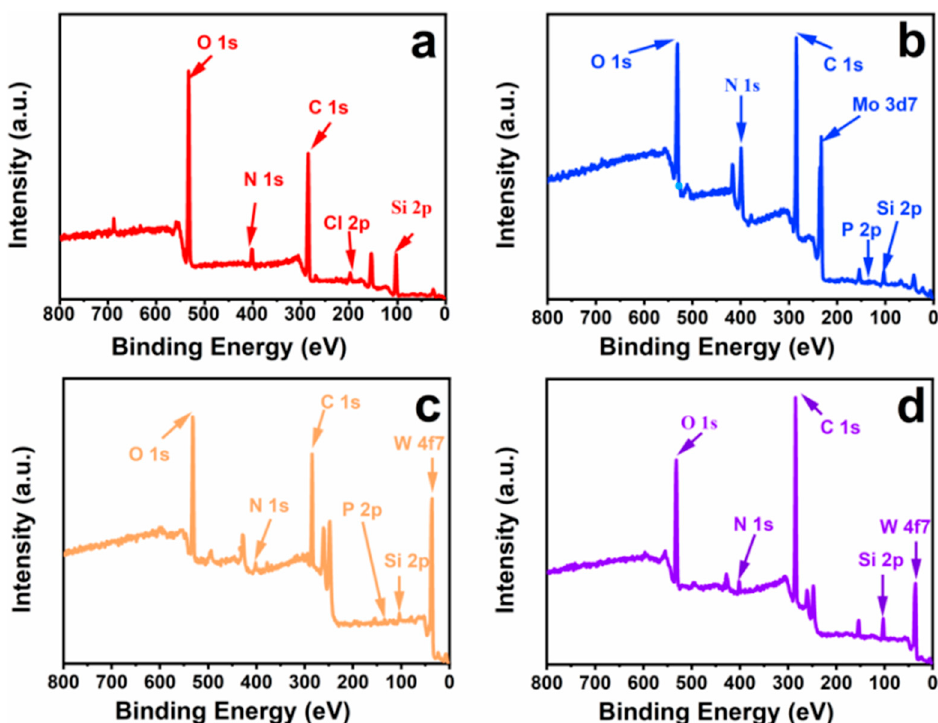
Figure 5. X-ray photoelectron spectroscopy of [BMIM]Cl-based MCF ( a ), [BMIM] 3 PMo 12 O 40 -based MCF ( b ), [BMIM] 3 PW 12 O 40 -based MCF ( c ) and [BMIM] 4 SiW 12 O 40 -based MCF ( d ).